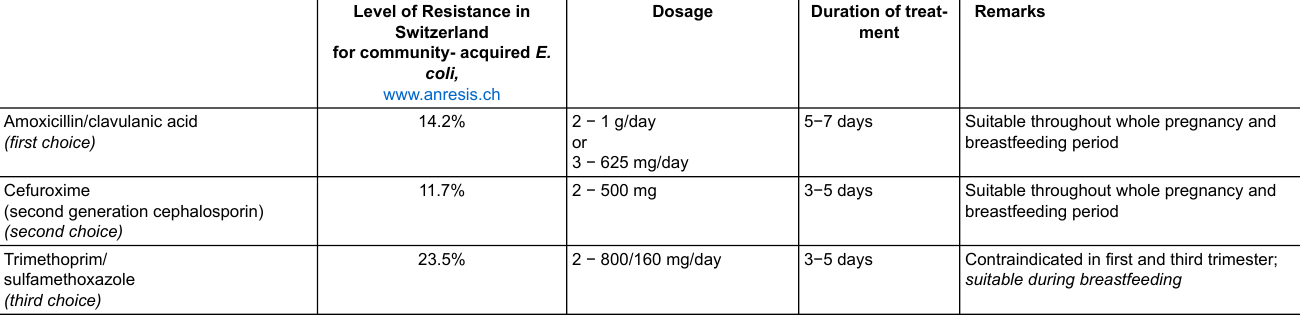
Table 5: Antibiotic therapy for uncomplicated UTI and pyelonephritis during pregnancy and